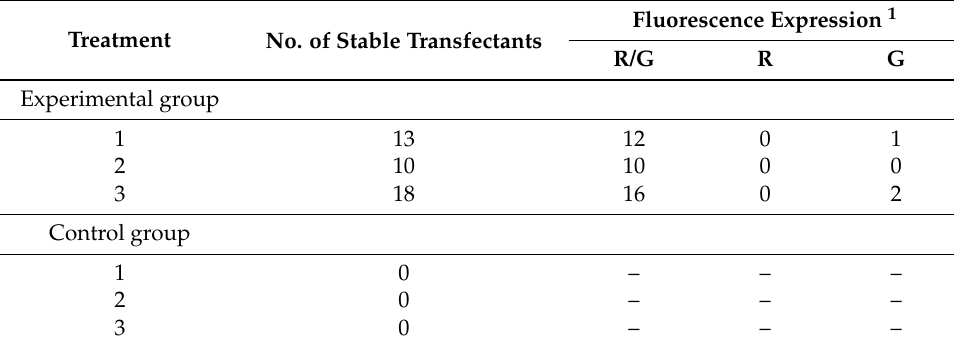
Table 1. Summary of Experiment